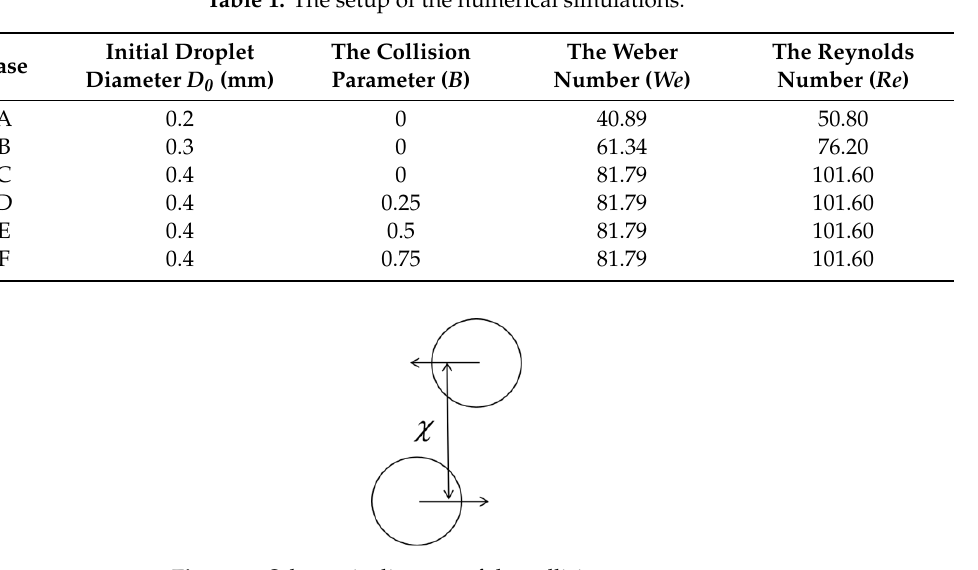
Table 1. The setup of the numerical simulations.